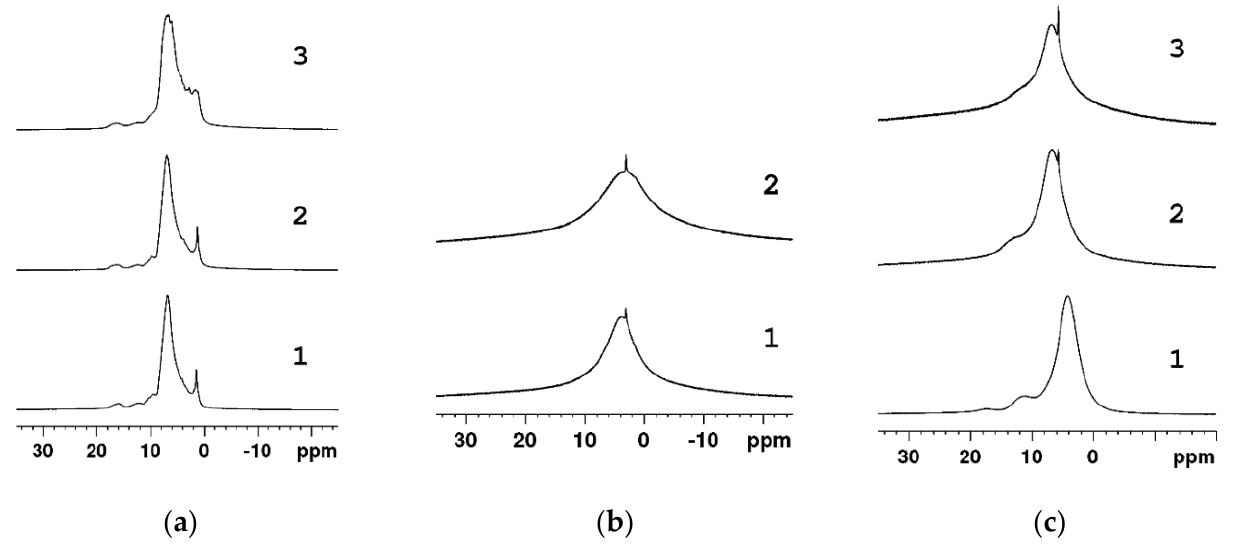
Figure 5. NMR spectra of synthesized mesogens: ( а ) — TDOBSH at 80 ° С (1), 50 ° С (2) and 30 ° С (3); ( b ) — TDOBSNa at 80 ° С (1), 24 ° С (2); ( c ) — TDOBSPyr at 80 ° С (1), 50 ° С (2), 30 ° С (3).